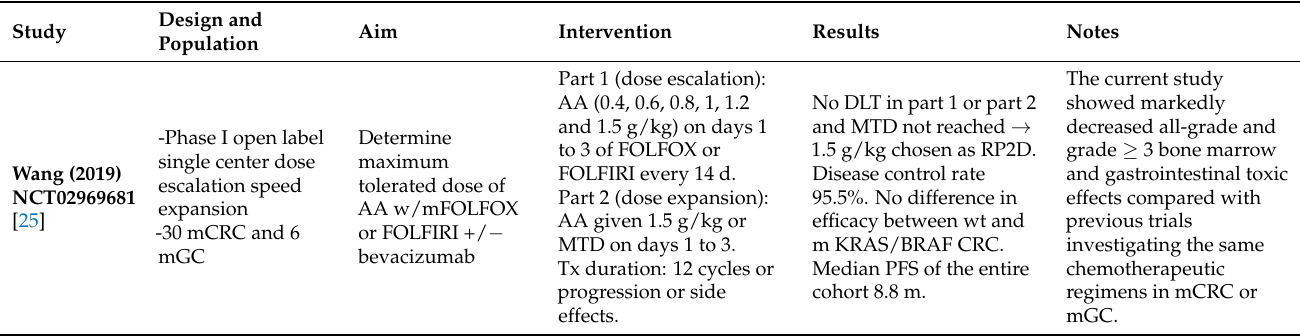
Table 1. Results of various trials using vitamin C as